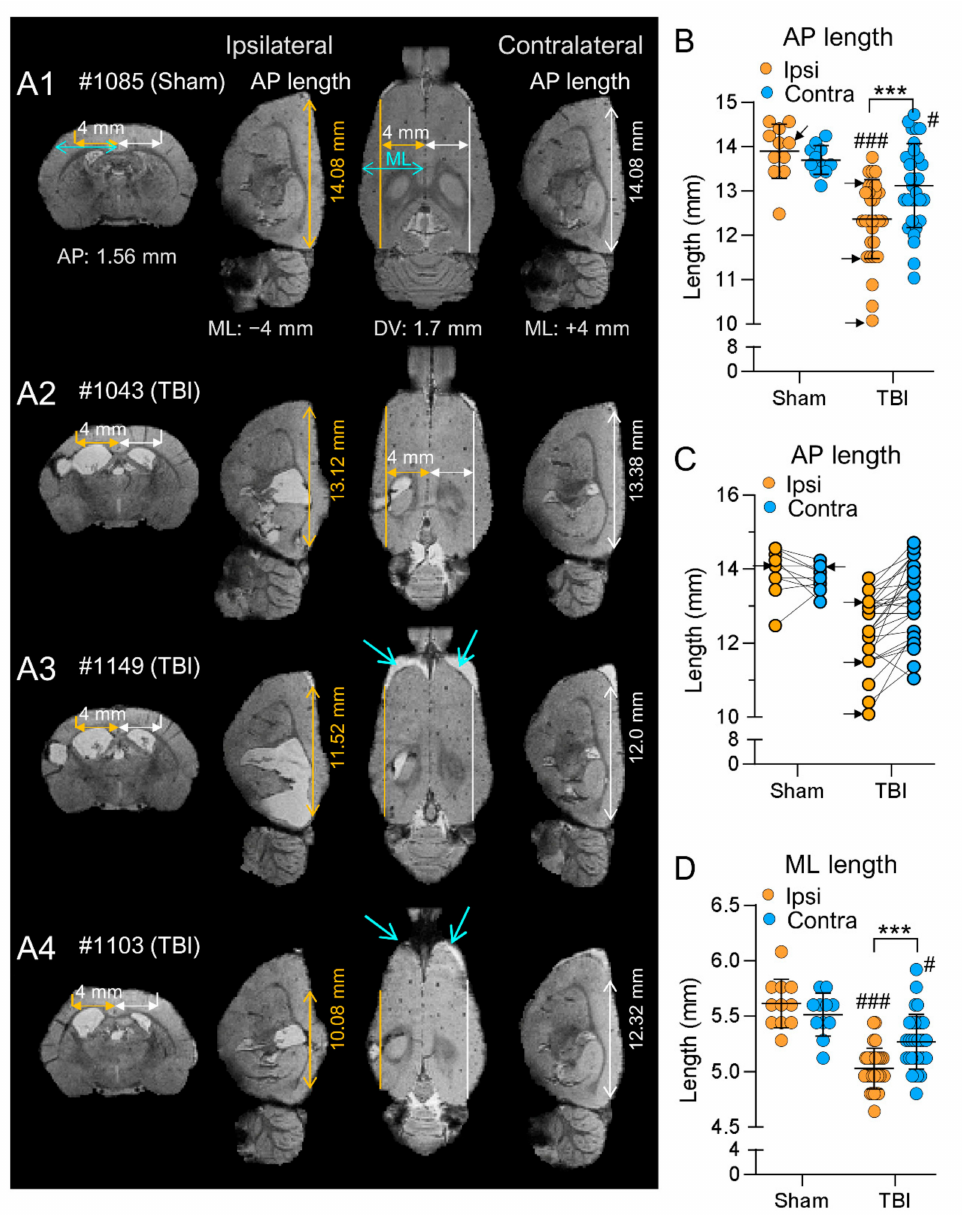
Figure 8. Anteroposterior and mediolateral shrinkage of the brain. In vivo magnetic resonance 3D multigradient echo (MGRE) images acquired at 5 months after TBI were used to estimate cortical shrinkage in the MRI cohort. ( A1 – A4 ) coronal, sagittal (ipsilateral and contralateral) and horizontal MGRE images of a sham rat ( A1 ) and TBI rats ( A2 – A4 ). Anteroposterior (AP) cortical shrinkage was estimated by measuring the distance between the rostral and caudal cortical surface (double-headed arrows) in the sagittal slice at 4 mm from the midline both ipsilaterally (orange) and contralaterally (white). Note the change in the shape of the ipsilateral cortex (sagittal images) in TBI rats, indicating the TBI-induced cortical atrophy (see also turquoise arrows in ( A3 , A4 )). Mediolateral (ML) shrinkage was assessed by measuring the distance between the midline and the lateral edge of the cortex (turquoise double headed arrow) in a horizontal slice at 1.7 mm below the pial surface at AP level − 1.56 (corresponding to the targeted location of the anterior intracortical electrode tip). ( B ) A dot plot showing the ipsilateral (orange) and contralateral (blue) cortical AP lengths ( y -axis) in the sham and TBI groups ( x -axis). Note that both the ipsilateral and contralateral cortical AP lengths were